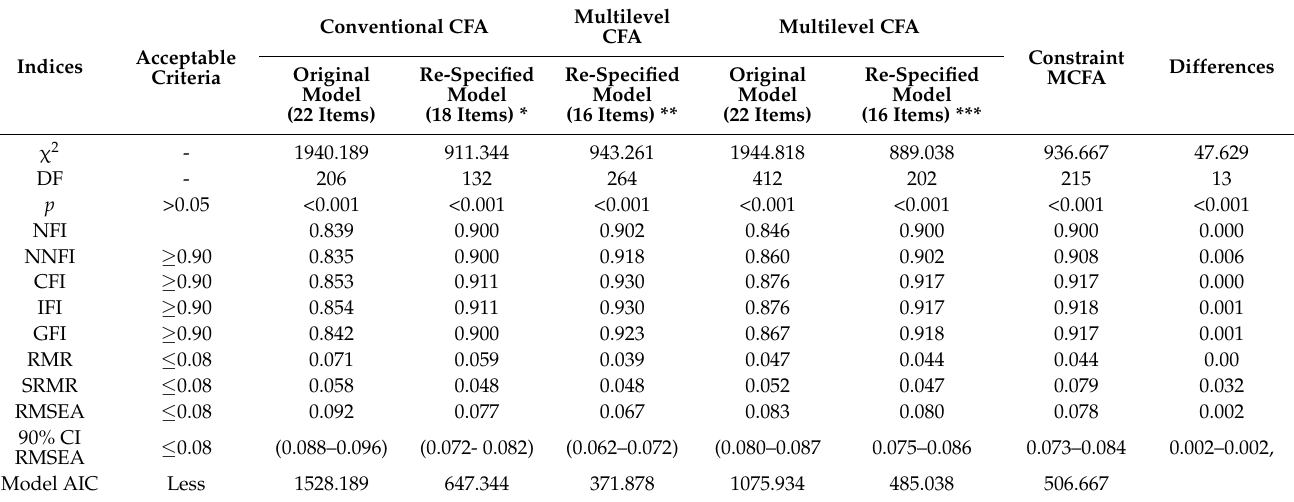
Figure 2. Wright map of the Impact of Event Scale-Revised (IES-R). Table 5. Goodness of fit indices for Impact of Events Scale-Revised (IES-R); single-level and two-level confirmatory factor analysis